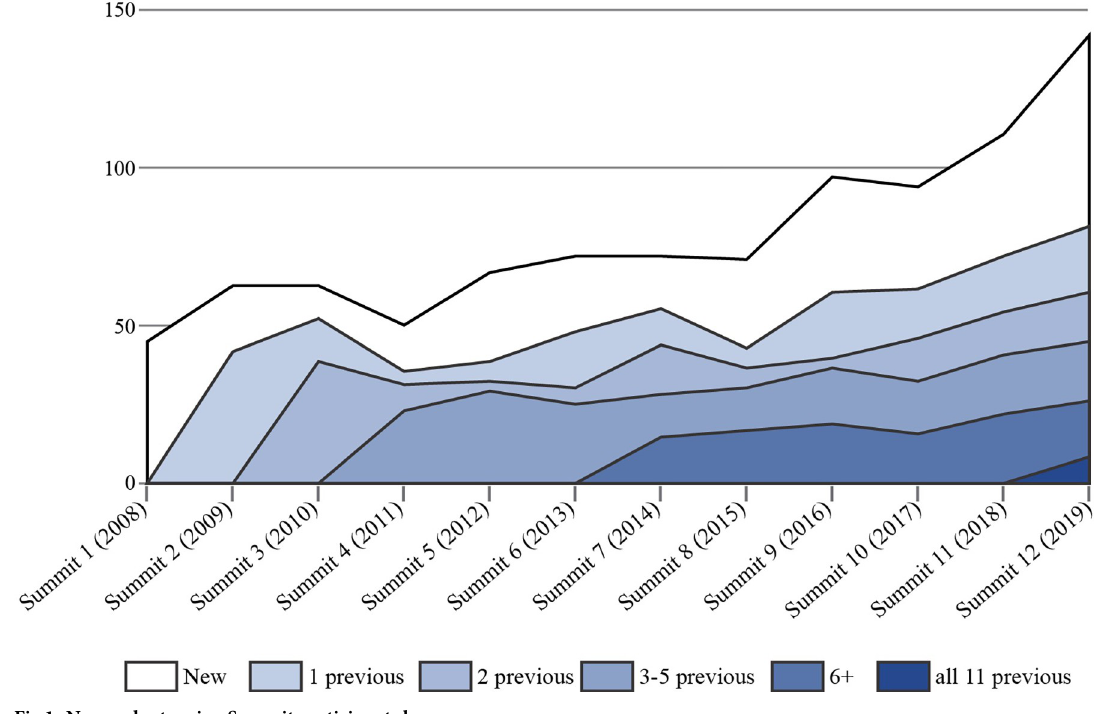
Fig 1. New and returning Summit participants by